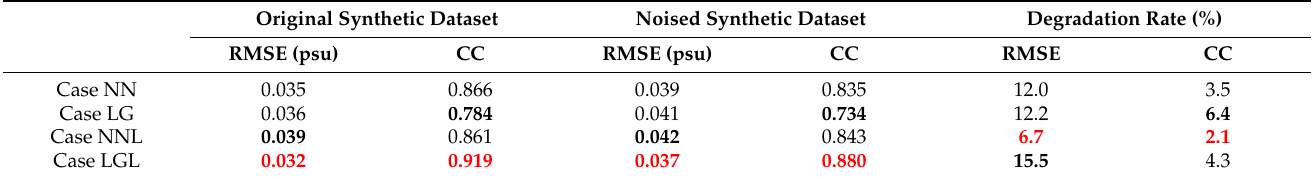
Figure 10. ( a ) Vertical distributions of CCs between the reconstructed data and the truth value for the four experiments with the original synthetic dataset. ( b ) Vertical distribution of CCs between the reconstructed data and the truth value for the four experiments with the noised synthetic dataset. ( c – f ) Vertical distribution of CCs of the individual experiments on the original versus the noised synthetic datasets. ( g ) Bar graphs of average CCs in the 1–2000 m range of the four experiments. ( h ) Noise-induced CC degradation rates of the four experiments. Table 2. RMSE, CC, and noise-induced RMSE and CC degradation rates for the four experiments. Red bold and black bold represent the best and worst performers for that metric,